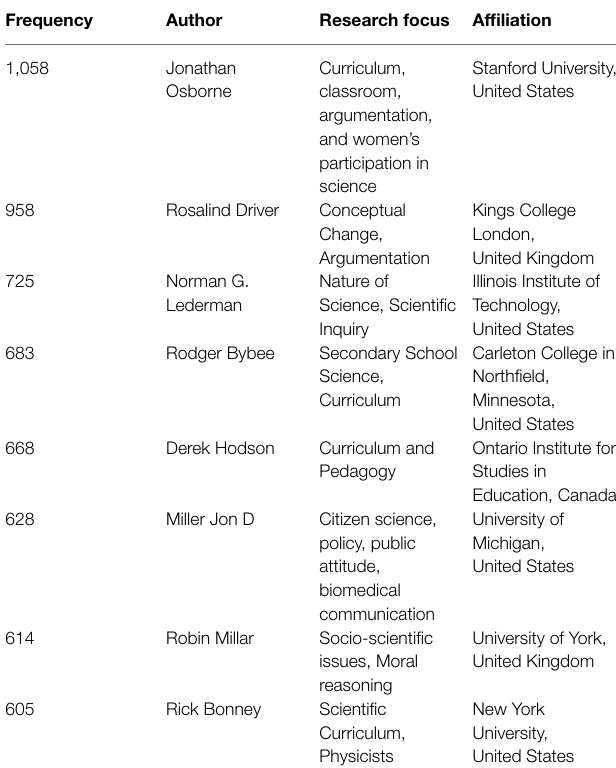
TABLE 3 | Highly co-cited authors in the intellectual structure of scientific literacy between the years 1980 to 2019 with a threshold of 600.